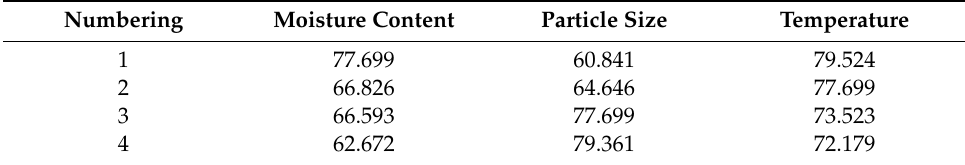
Table 5. Extremum di ff erence analysis of methane adsorption principle of silica